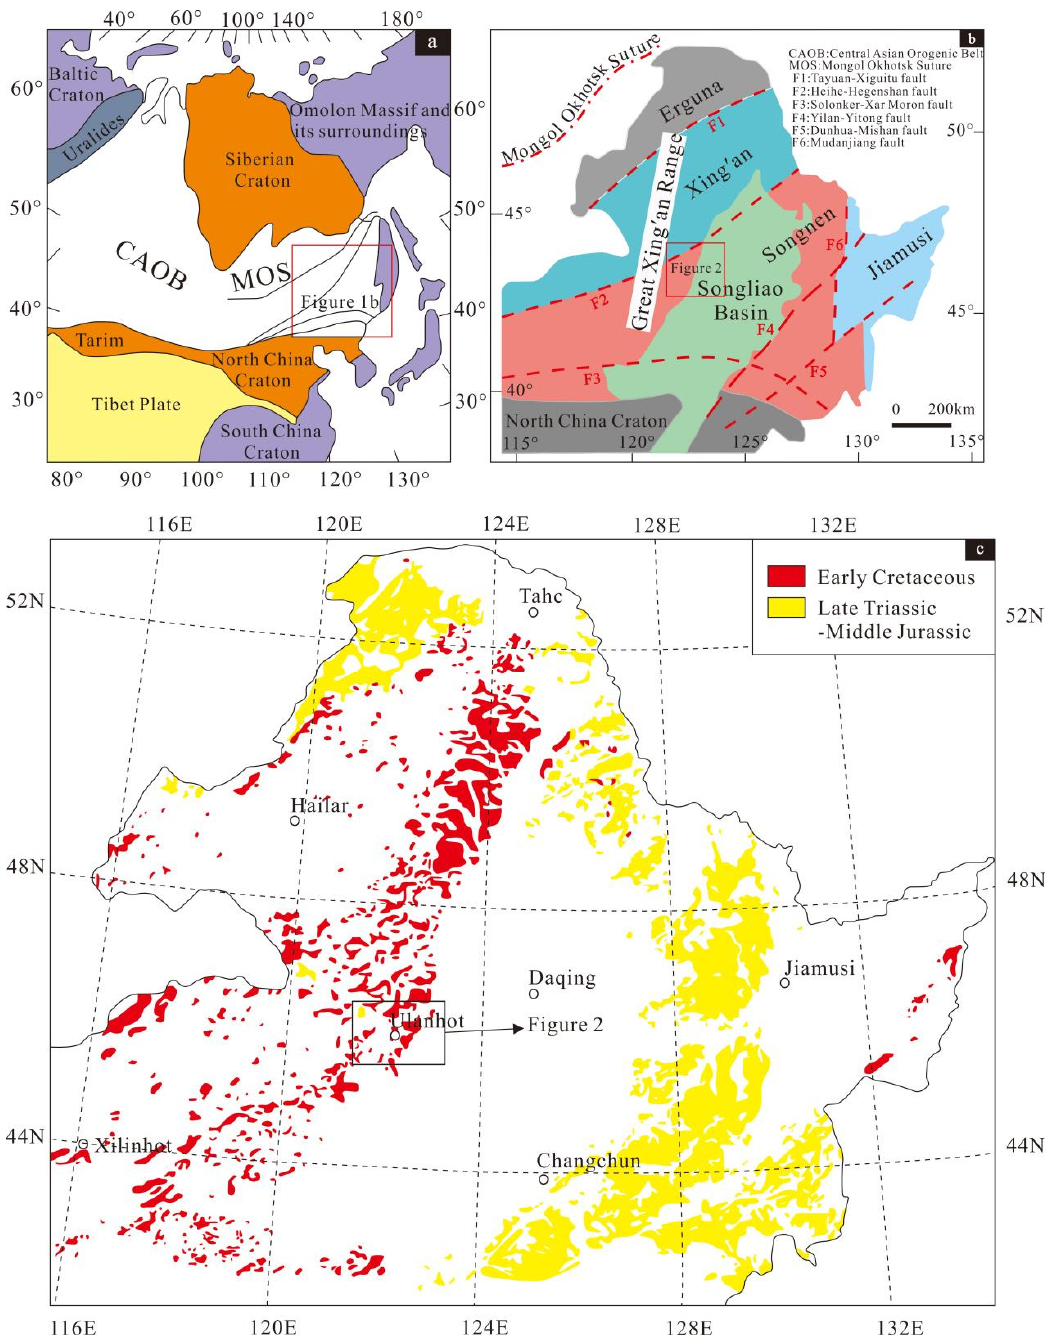
Figure 1. ( a ) Tectonic sketch map of Northeast Asia and the position of Figure 1b (modified after Wu et al. [2] and Zhang et al. [63]). ( b ) Simplified tectonic map of NE China (modified after Wu et al. [2] and Wang et al. [65]) and the position of Figure 2. ( c ) Distribution of the Late Mesozoic granitoids in NE China (modified after Wu et al. [2], Li et al. [38], and Pang et al. [39]).